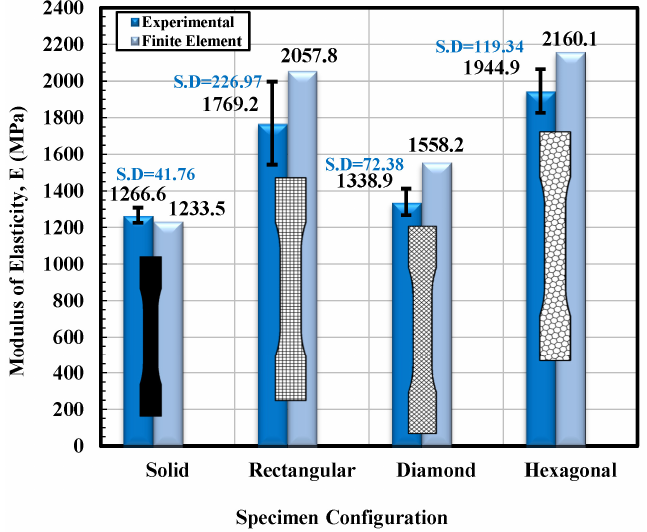
Figure 16. Apparent modulus of elasticity versus specimen configuration for both experimental and finite element analysis.